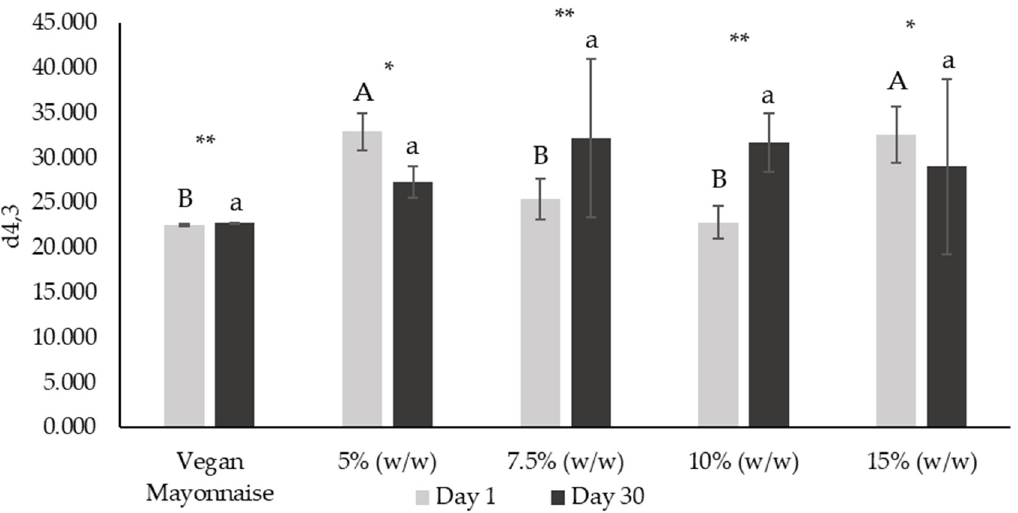
Figure 10. De Brouckere diameter (d 4,3 ) from droplet size distribution of emulsions with 5, 7.5, 10 and 15% ( w / w ) of miso paste and standard emulsion, measured 1 and 30 days after emulsion preparation. Different letters indicate significantly different results ( p < 0.05) according to Tukey test. One asterisk and two asterisks represent non significantly ( p > 0.05) and significantly ( p < 0.05) different results, respectively, according to the t -Test.